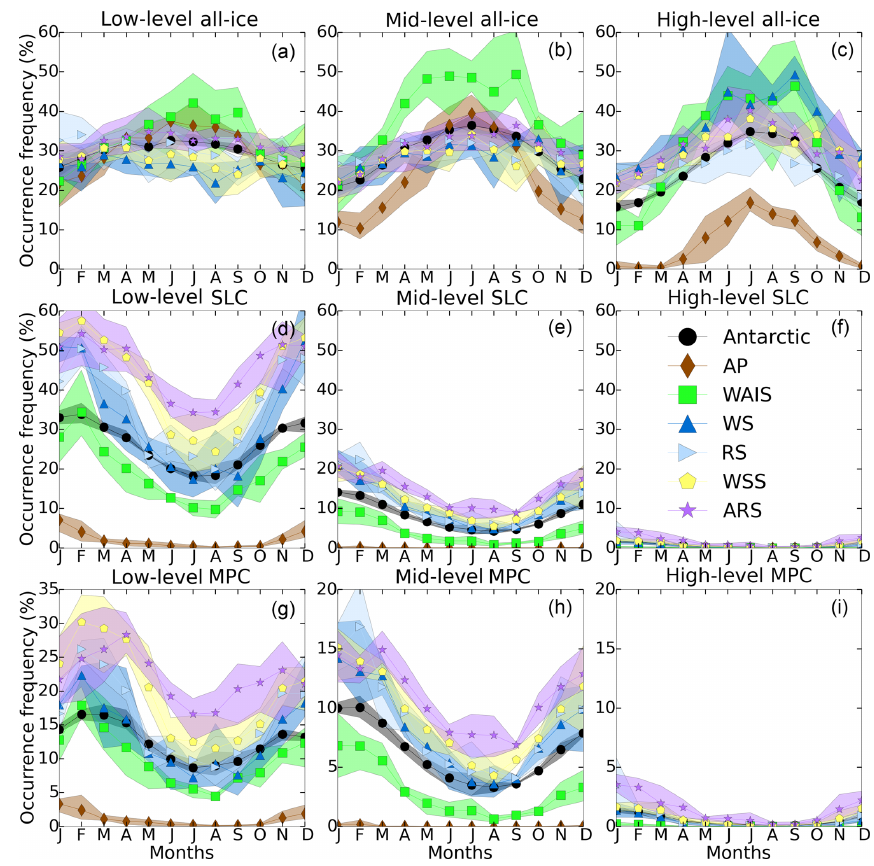
Figure 10. (a–c) Four-year (2007–2010) average monthly time series of the low (a) , middle (b) and high-level (c) all-ice fraction for the different Antarctic regions defined in Fig. 4c. (d–f) Same as top row but for the SLC fraction. (g–i) Same as top row but for the MPC